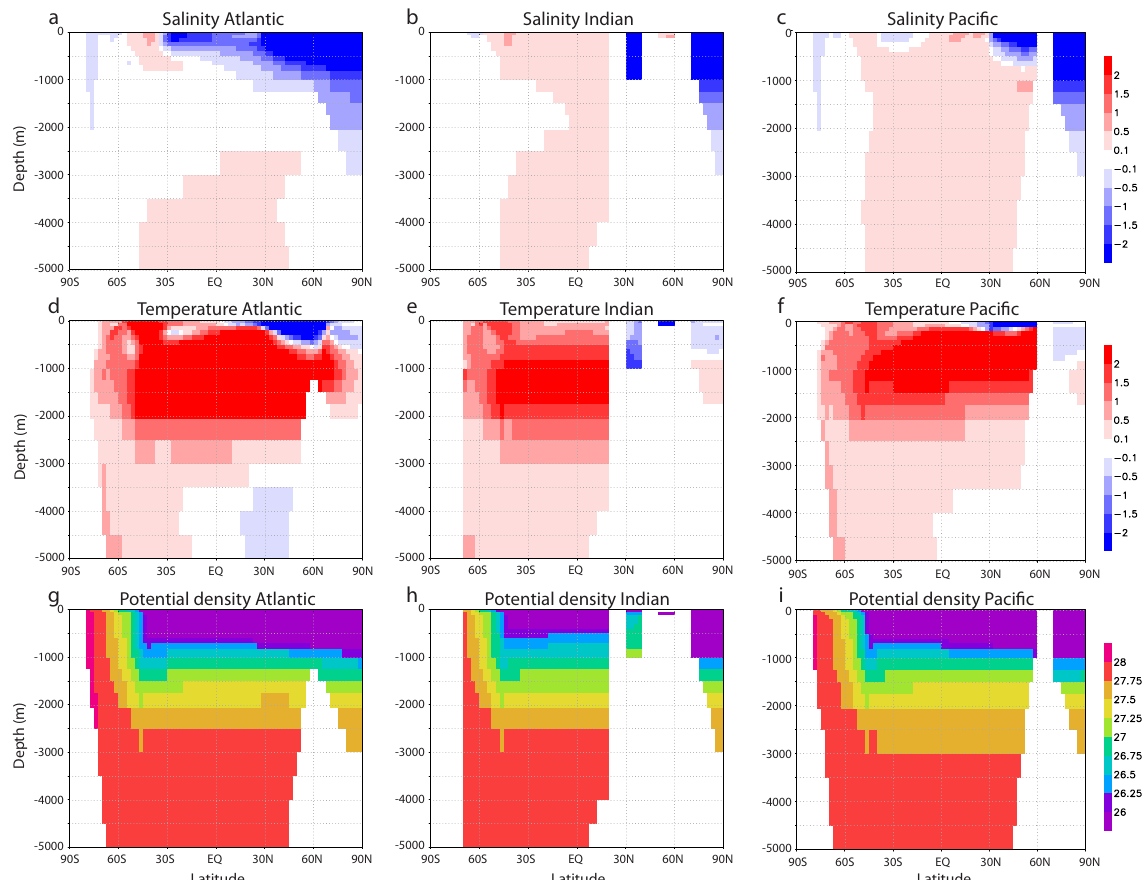
Fig. 4. Zonally averaged salinity (permil) and temperature ( ◦ C) anomalies, and density (kgm − 3 ) for the simulation during the Preindustrial with a fresh water flux added in the North Atlantic of 0.5Sv during 400yr: (a, b, c) salinity; (d, e, f) temperature; (g, h, i) density. The anomalies of temperature and salinity refer to the difference between the collapse state of the AMOC compared to the control state (years1390–1400 minus years990–1000). The density is taken at the years1390-1400. The three basins are: (a, d, g) Atlantic, (b, e, h) Indian and (c, f, i)